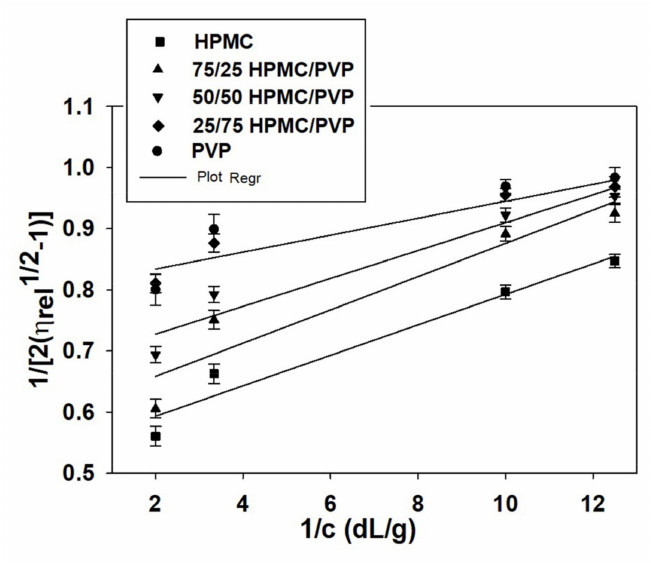
Figure 3. Rao plots for HPMC, PVP, and HPMC/PVP mixture in water at different mixing ratios and 25 ◦